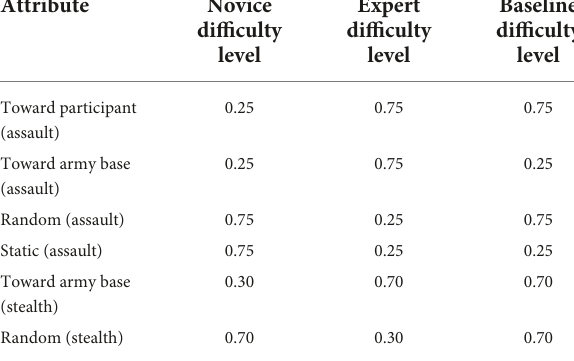
TABLE 2 Variation in probabilities of movement with respect to different difficulty